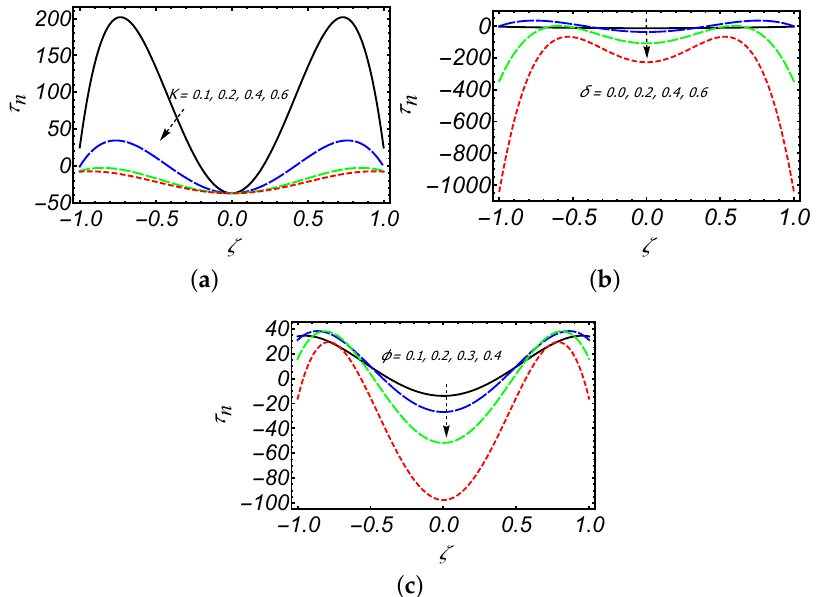
Figure 12. Behavior of τ n due to ( a ) K when φ = δ = 0.2, ( b ) δ when K = δ = 0.2, ( c ) φ when K = δ = 0.2.